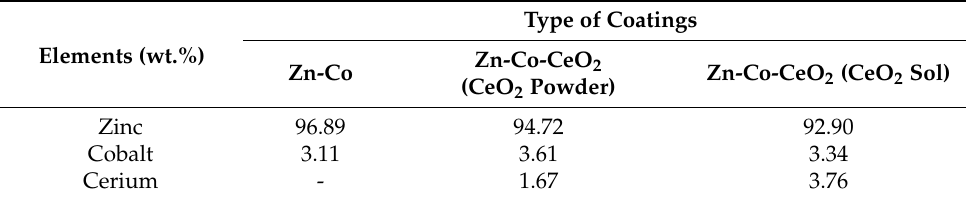
Table 1. The chemical composition of the Zn-Co and Zn-Co-CeO 2 composite coatings. Elements (wt.%)